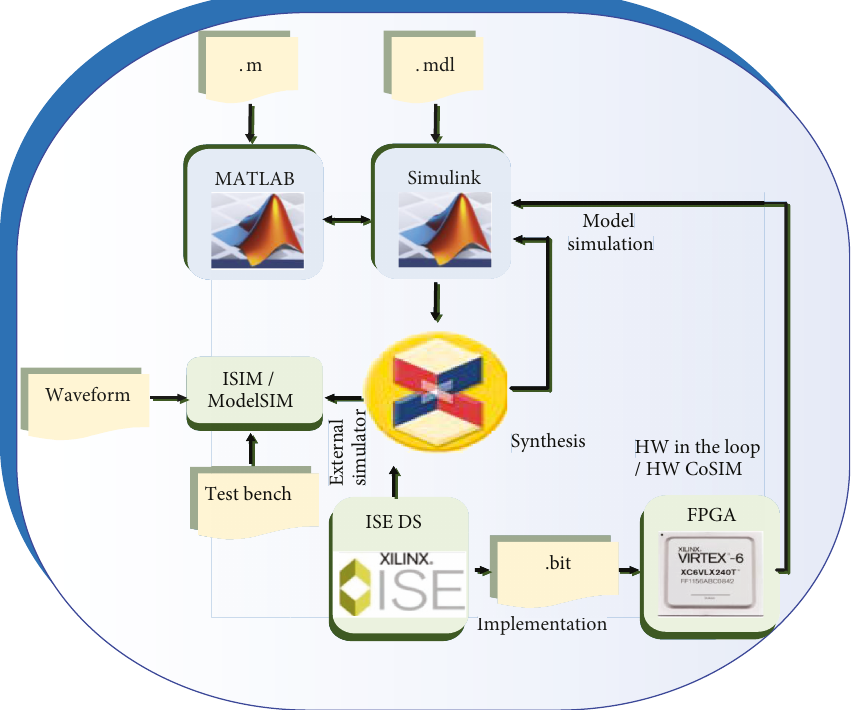
Figure 10: Flow conception of the System Generator tool.